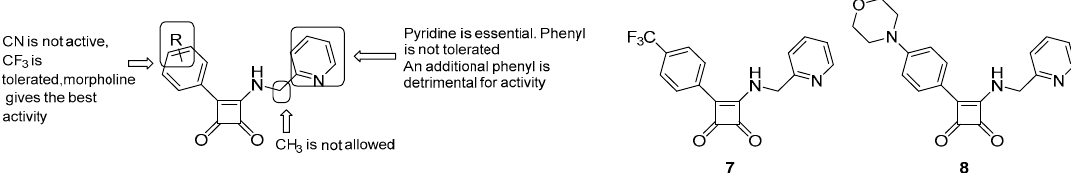
Figure 19. SAR analysis for the squaramide class and chemical structures of hit 7 and its improved analogue 8.